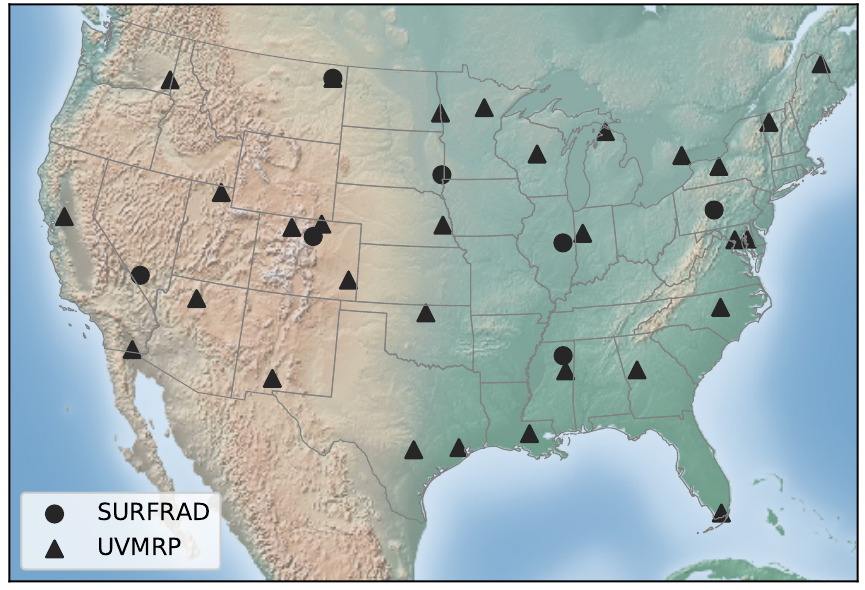
Figure 1. Study site distribution map. The triangular markers denote the site locations of the UV-B Monitoring and Research Program (UVMRP) network. The circle markers denote site locations of Surface Radiation Budget Network